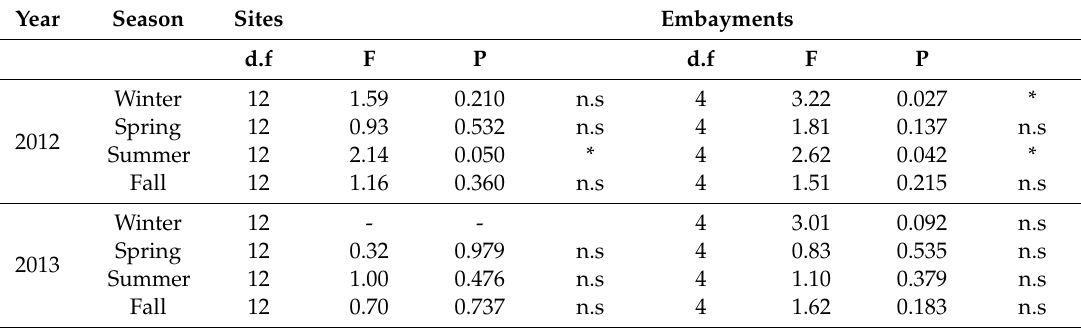
Table 3. One-way ANOVA result of analyses comparing mesozooplankton density among sampling sites and embayments of the Maryland Coastal Bays in the di ff erent seasons in 2012 and 2013. d.f, degree of freedom; Fs, F-value; P, probability value; * 0.05 > p > 0.01; n.s, p > 0.05. There were insu ffi cient data to perform ANOVA in winter